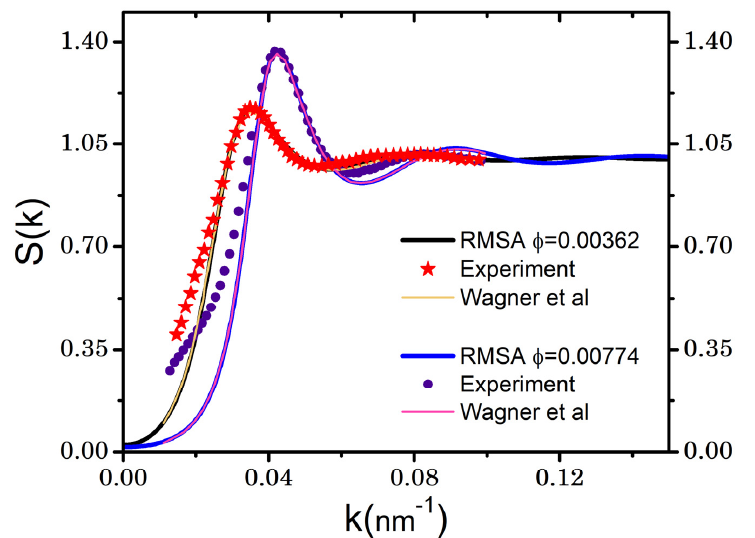
Figure 3. Experimental data of S ( k ) given by star and dot symbols was taken from Wagner, J. et al. [3]. Adapted with permission from Ref. [3]. Copyright 2022 IOP Publishing, Ltd. Present manuscript’s fits of S ( k ) with the RMSA theory (continuous black and blue lines) shows perfect coincidence with the fits (magenta and red color lines) made by Wagner, J. et. al. [3]. Adapted with permission from Ref. [3]. Copyright 2022 IOP Publishing, Ltd.